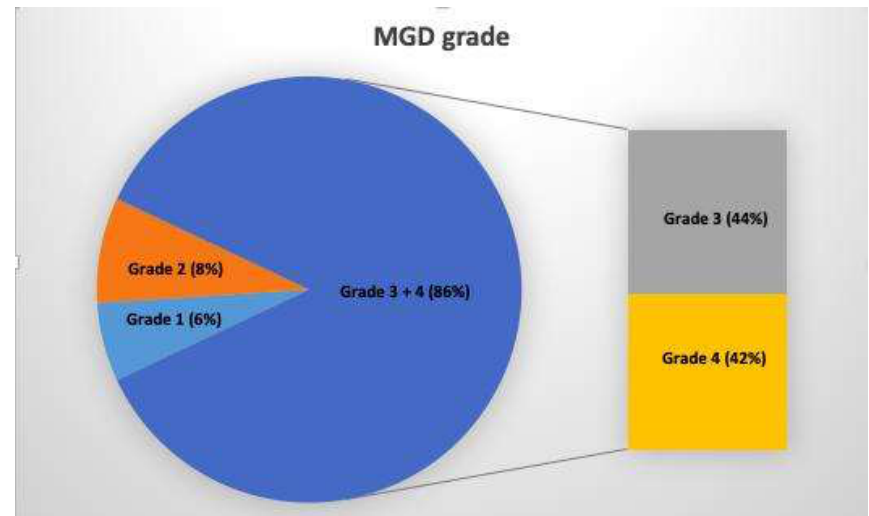
Figure 2. A relevant prevalence of the severe involvement of the meibomian gland was found (85% grade 3 + 4) in patients with systemic sclerosis (SSc) using meibography. MGD: meibomian gland disease.